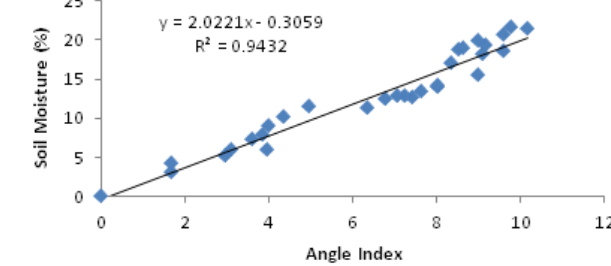
Fig. 10 Relationship between estimated soil moisture content